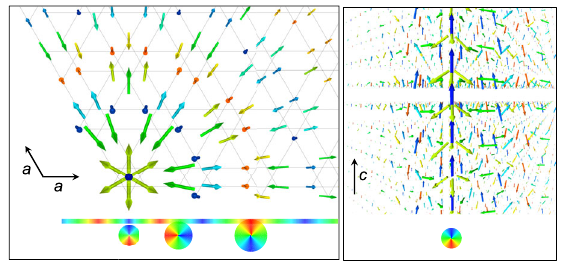
FIG. 6. Chiral lump pattern as obtained in first approximation from the chiral correlation function: left, top view projection; right, perspective side view. Chiral spin correlations are mapped around a trigonal site, which is considered as the origin of a magnetic lump. Neighboring spins are scaled with distance from the center for emphasis only analog to Fig. 4 (right). The color wheel illustrates the spin angle and phase of the cylindrical cycloid. Spins show upward (blue) in the center of the lump, which reflects the polar anisotropy. This choice is arbitrary with respect to the degeneracy of spin